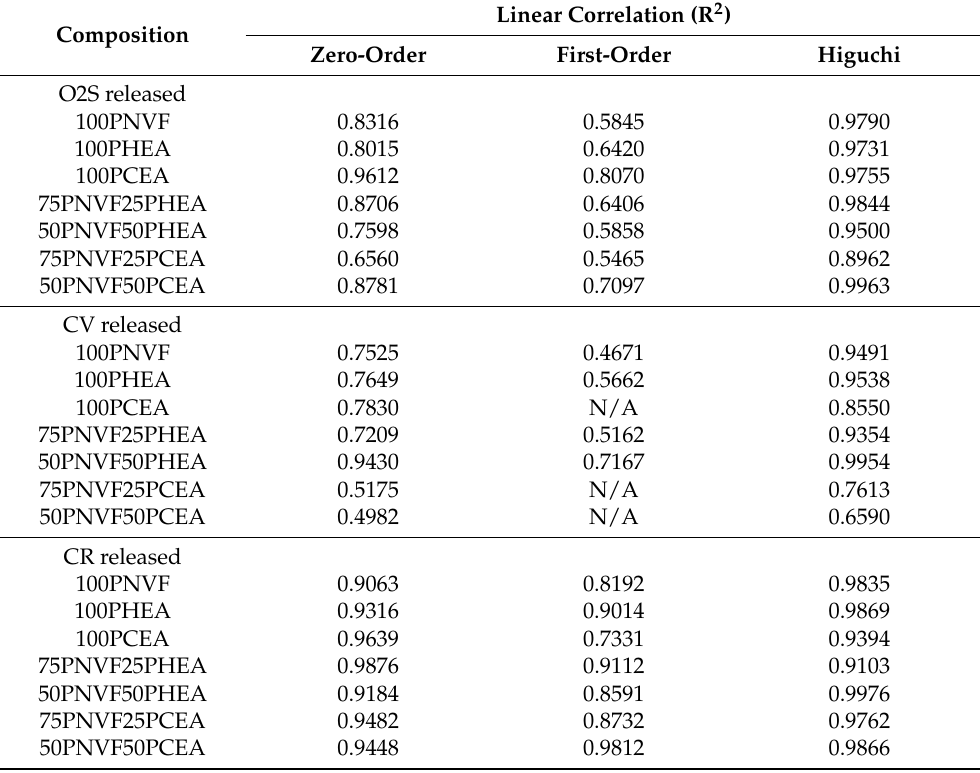
Table 4. Linear correlation obtained from different kinetic